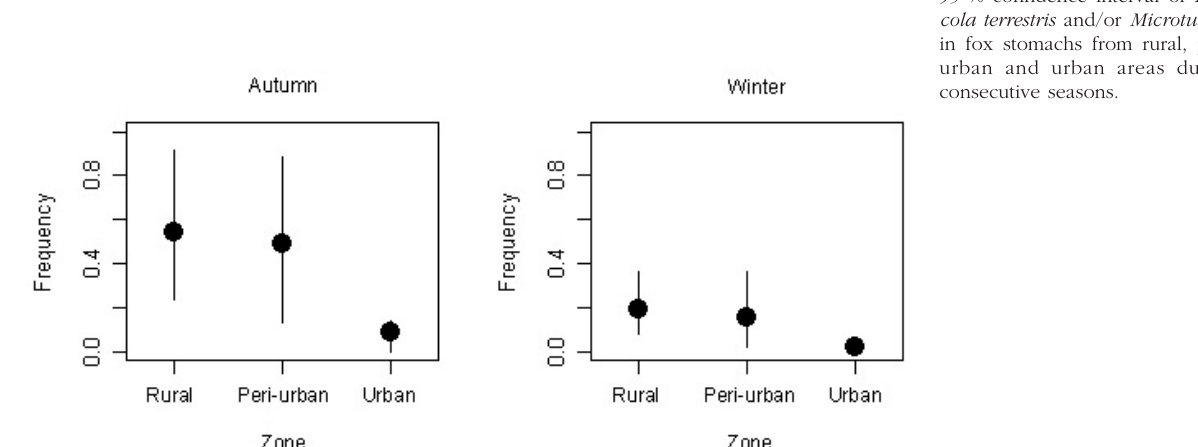
Fig. 3. – Occurrence frequency and 95 % confidence interval of Arvi- cola terrestris and/or Microtus sp. in fox stomachs from rural, peri- urban and urban areas during consecutive